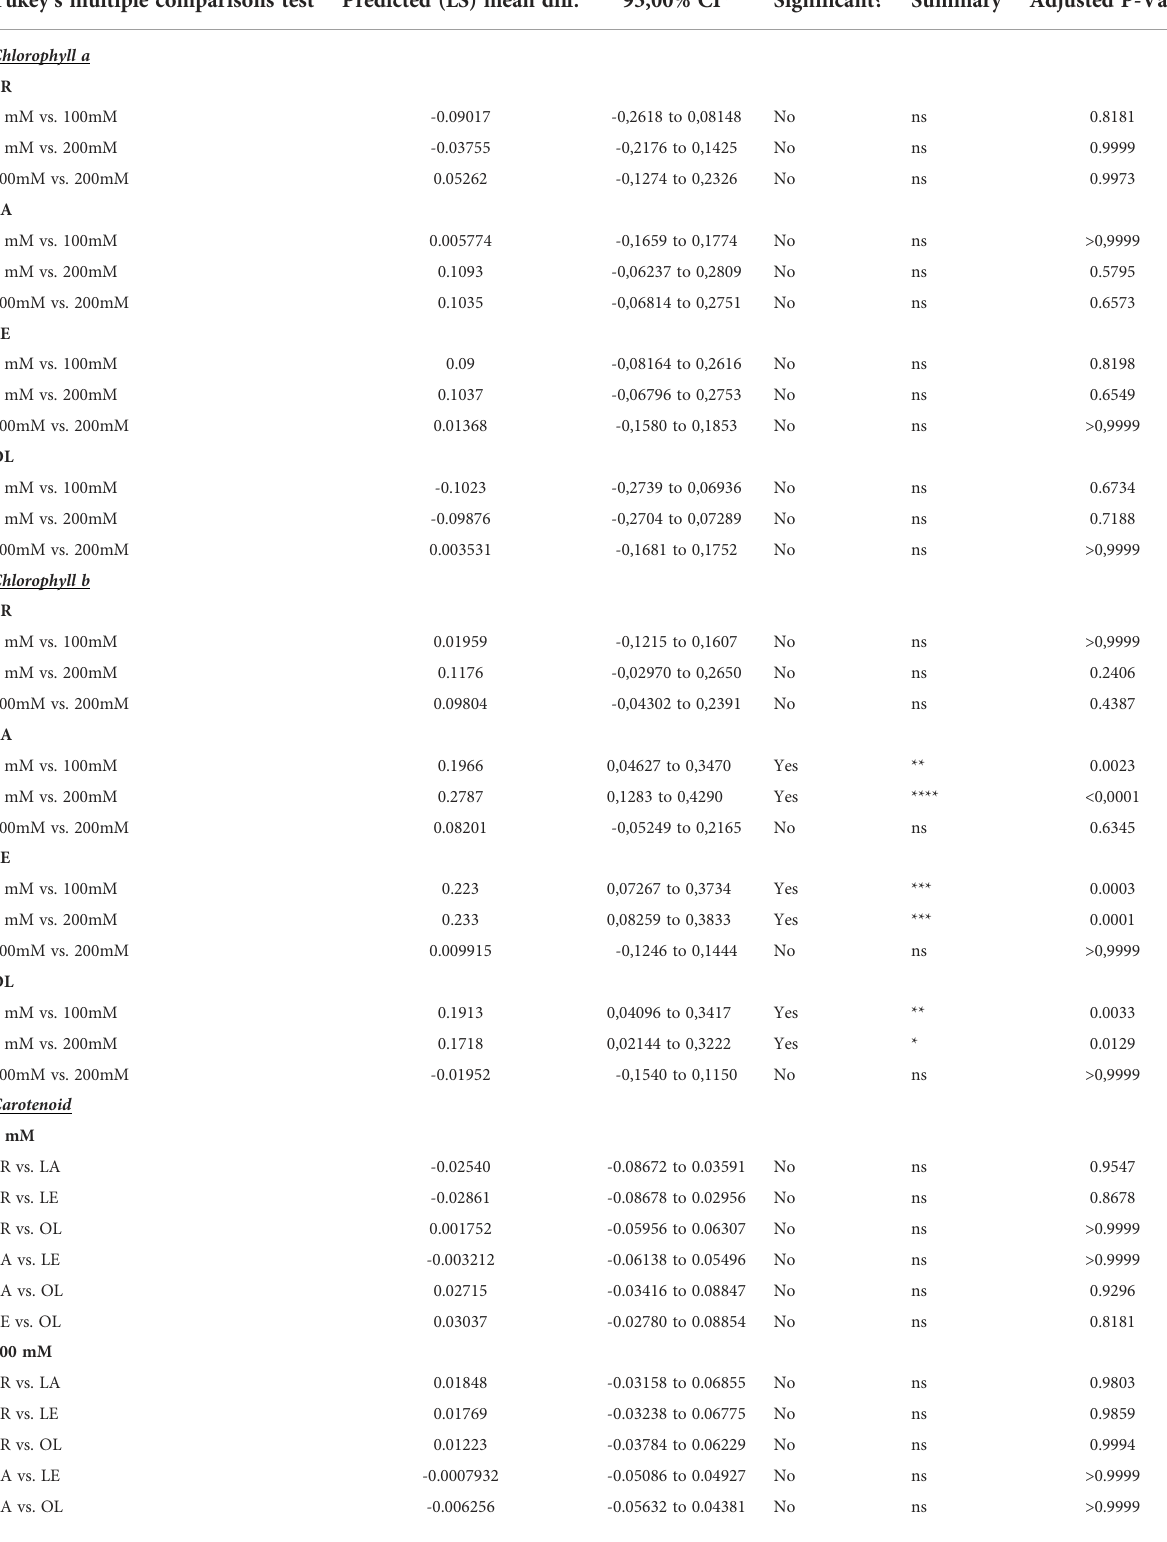
TABLE 1 Post-hoc test results of two-way ANOVA analyses on pigment data, considering the Cultivar factor, with exception of Carotenoid data where Treatment factor was